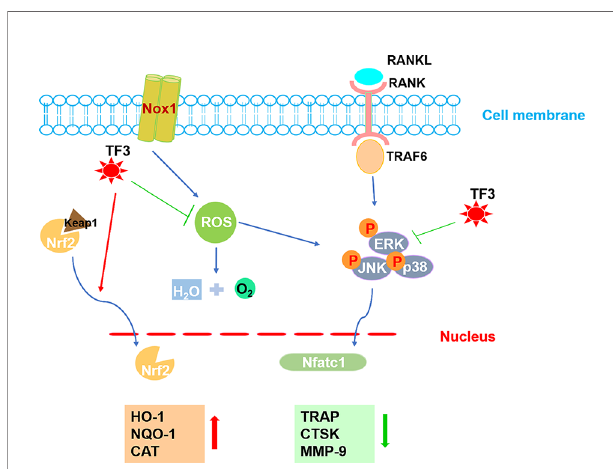
FIGURE 7 | A pattern for the inhibitory effect of TF3 on osteoclastogenesis. Beginning with RANKL binding to RANK, the MAPK pathway is activated, causing the ampli fi cation of NFATc1. Several osteoclast-speci fi c genes, such as TRAP, CTSK, and MMP-9 are upregulated. ROS are involved in this process. Our results demonstrated that TF3 inhibits osteoclastogenesis by enhancing the expression of Nrf2-mediated antioxidant enzymes as well as by inhibiting the phosphorylation of the MAPK pathway. The upward-pointing bold arrow shows the enhanced effects of TF3, and the downward-pointing bold arrow displays the inhibitory effects of